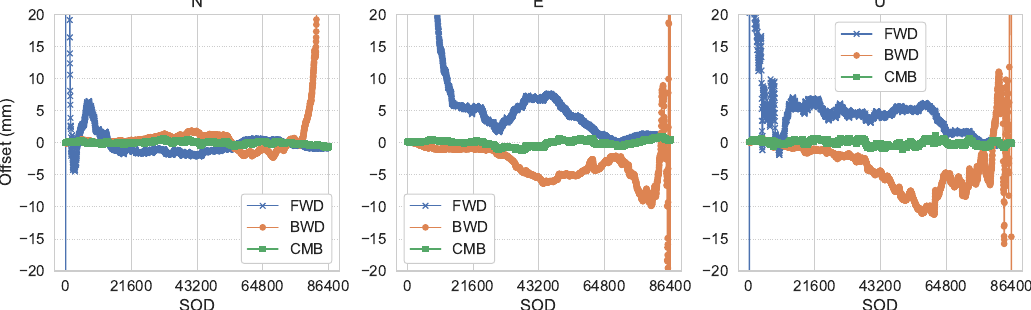
Figure 5. Daily PPP combined (CMB) solution at Aboa on 1 January 2017. Forward (FWD) and backward (BWD) solutions were combined using the inverse variance weighting approach. The solutions are expressed in terms of North, East, Up (N,E,U) offsets with respect to the mean position. The time is expressed in the seconds of day